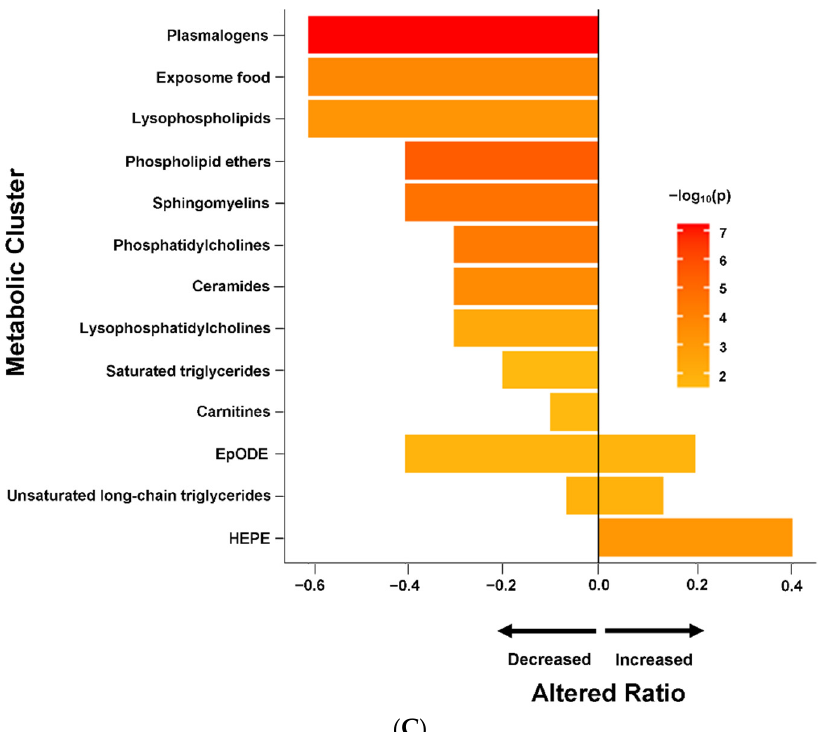
Figure 2. Chemical enrichment analyses using ChemRICH. HEPE: hydroxy eicosapentaenoic acid; ME/CFS: myalgic encephalomyelitis/chronic fatigue syndrome; sr-IBS: self-reported physician diagnosed irritable bowel syndrome. The length of the bar represents altered ratio for each metabolic cluster. A bar restricted to the left of the centered vertical line indicates a metabolic cluster that is lower in ME/CFS patients. A bar restricted to the right of the centered vertical line indicates a metabolic cluster that is higher in ME/CFS patients. A bar that crosses the vertical line indicates a metabolic cluster that is dysregulated in mixed directions. ( A ) All ME/CFS vs. controls. ( B ) Female ME/CFS vs. female controls. ( C ) ME/CFS without sr-IBS vs. controls without sr-IBS.